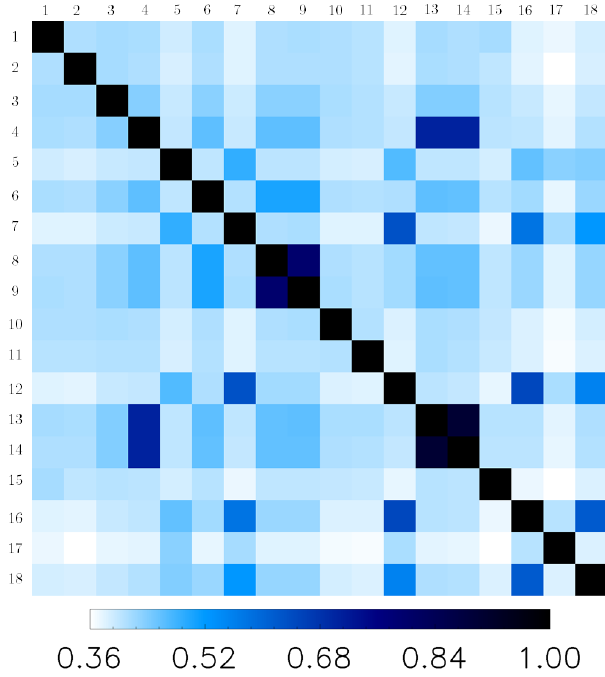
(cid:112) H ( Y 1 ) H ( Y 2 ) .